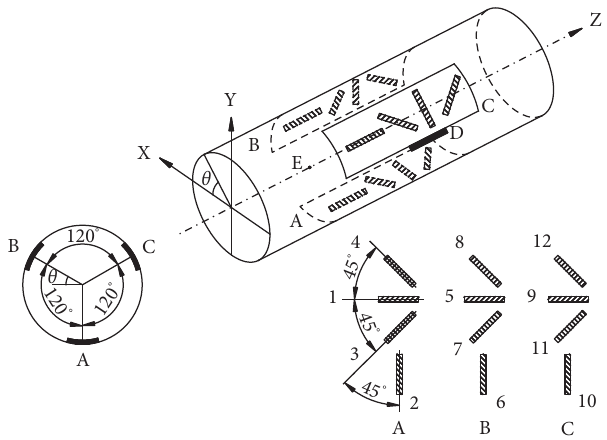
Figure 1: Improved hollow inclusion technique [19].